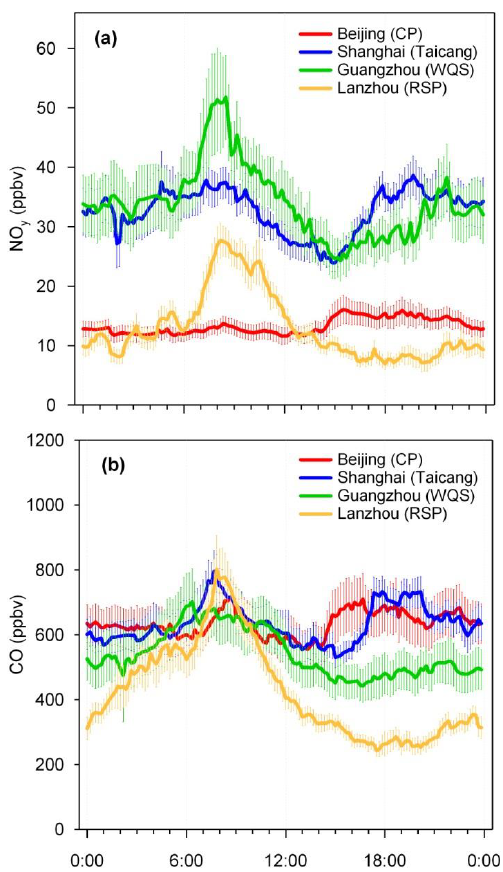
Figure 2. Observed average diurnal profiles of (a) NO y and (b) CO in the four cities. The data time interval is 10min, and the error bar is standard